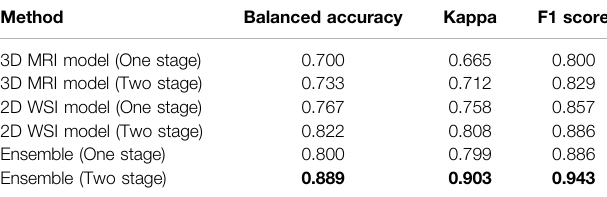
TABLE 2 | Experimental performance of the 2D WSI model for ablation on validation data. Method